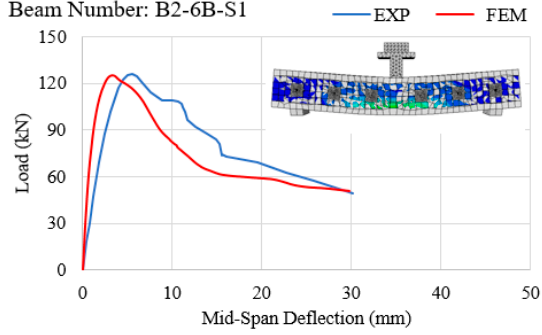
Figure 21. Load vs. mid-span deflection for B2-6B-S-1.